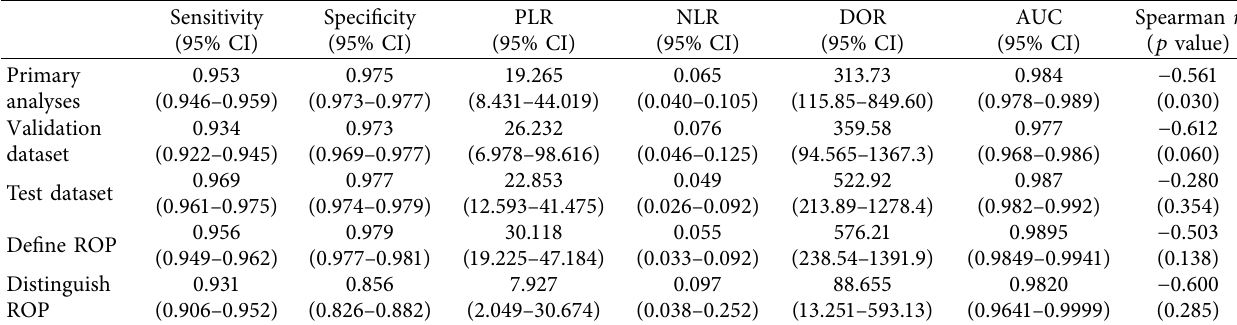
Table 2: The results of primary and subgroup